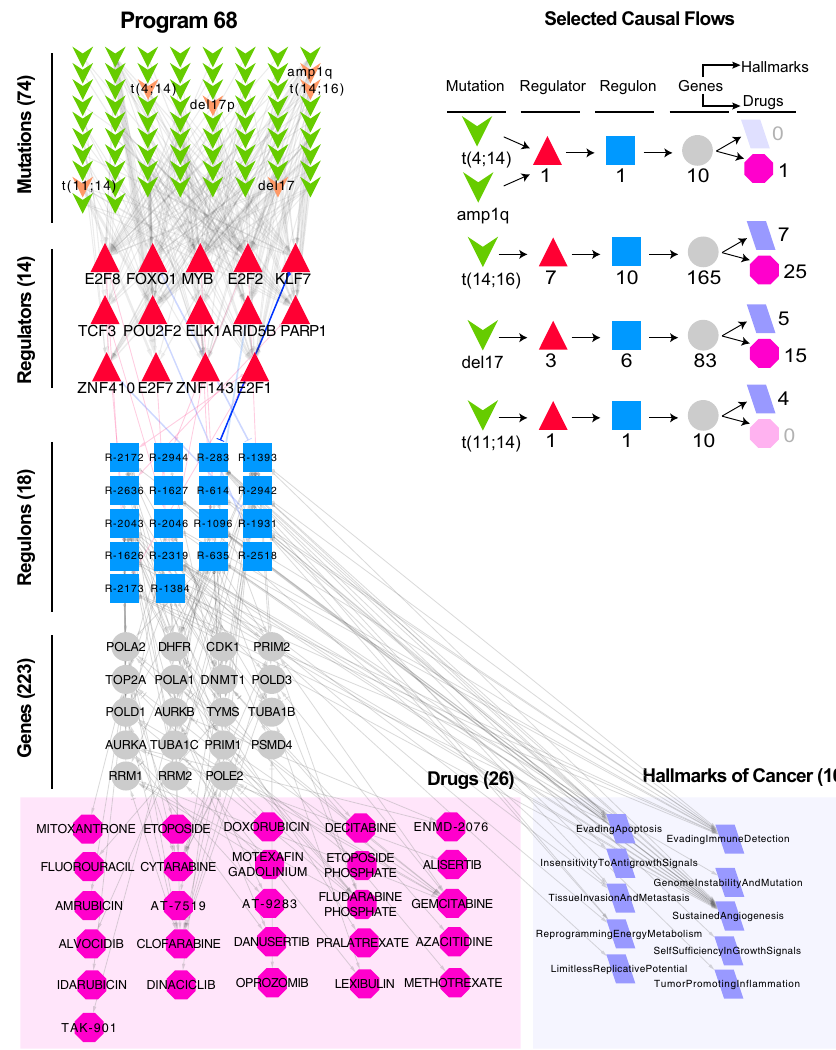
Fig. 3 Network visualization of Pr-68. The regulons comprising program Pr-68 are represented as blue boxes with their associated regulators (red triangles) and putative causal genetic abnormalities (green chevrons). Hallmarks of cancer that are enriched in these regulons are highlighted by purple parallelograms, and drugs that target genes (gray) within these regulons are highlighted by pink